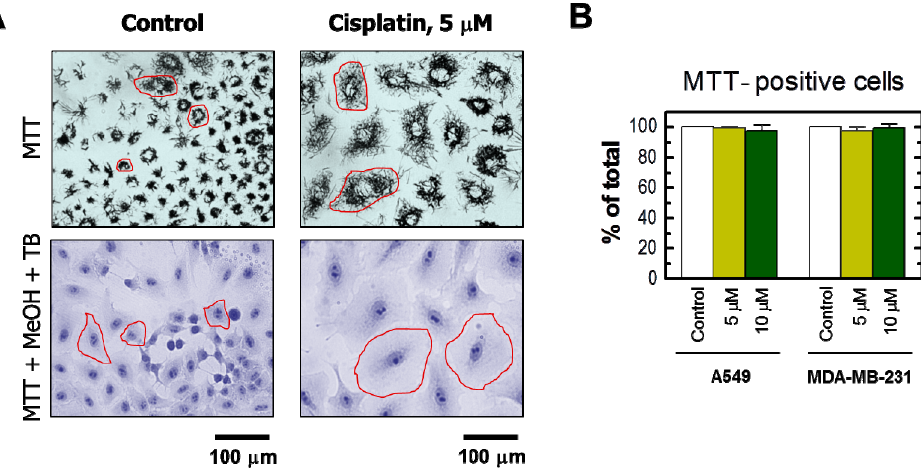
Figure 2. ( A ) Representative bright-field microscopy images depicting the metabolic activity of A549 cells that were incubated with 0 μ M (control) or 5 μ M cisplatin for 3 days. Metabolic activity was measured by the ability of the cells to convert the yellow MTT to its purple formazan metabolite, which appears as dark granules and crystals. Upper row: images were acquired after incubation of cells with MTT for ~1 h. Lower row: images were acquired after incubating cells with MTT (~1 h), fixing them in methanol (MeOH) for 0.5 min to dissolve the MTT metabolite, removing the resulting purple medium, and mildly staining the fixed cells with trypan blue (TB) to visualize their morphology. All images were acquired at the same magnification. The border of some cells is marked in red for clarity. Images acquired for the MDA–MB-231 cell line were virtually identical to those shown for A549 (also see Figure 2A); ( B ) percentages of MTT-positive cells after the same treatments for both A549 and MDA–MB-231 cell lines. Bars, SE.